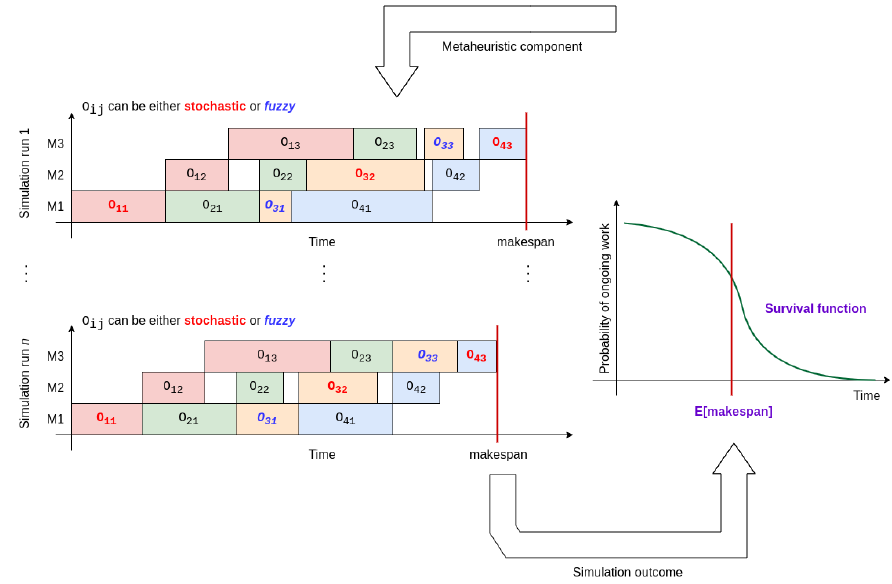
Figure 1. A schematic representation of the main characteristics in our